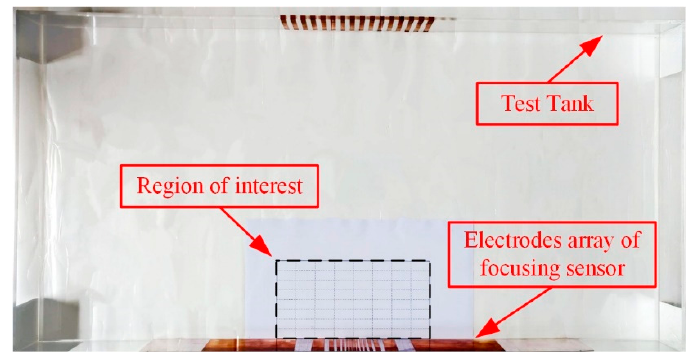
Figure 15. The experimental system for OEIT.